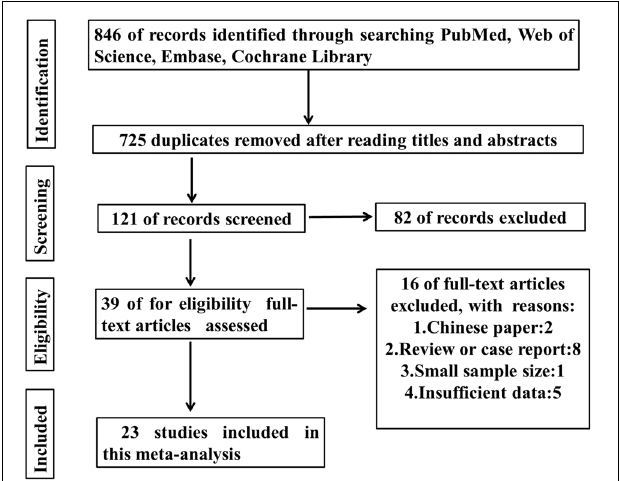
FIGURE 1 | Flow diagram of study